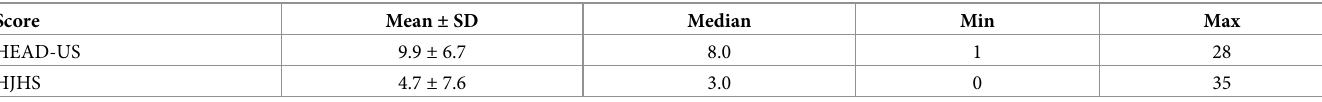
Table 2. The results of HJHS and HEAD-US